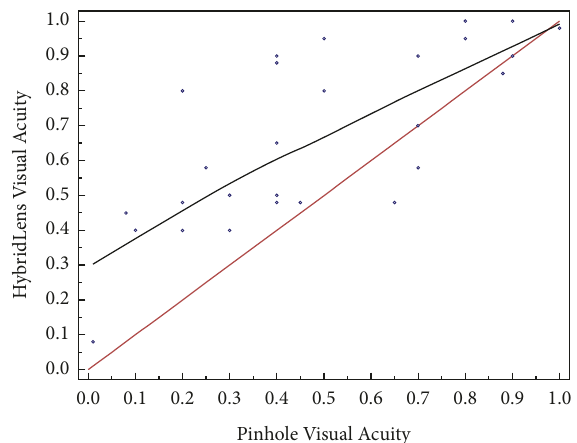
Figure 2: Correlation between measurements of hybrid contact lens visual acuity and pinhole acuity.